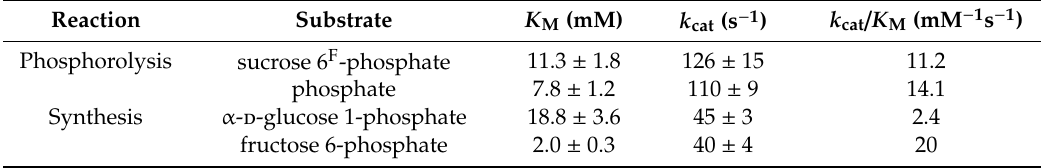
Table 1. Apparent kinetic parameters of I. coccineus sucrose 6 F -phosphate phosphorylase at 35 ◦ C